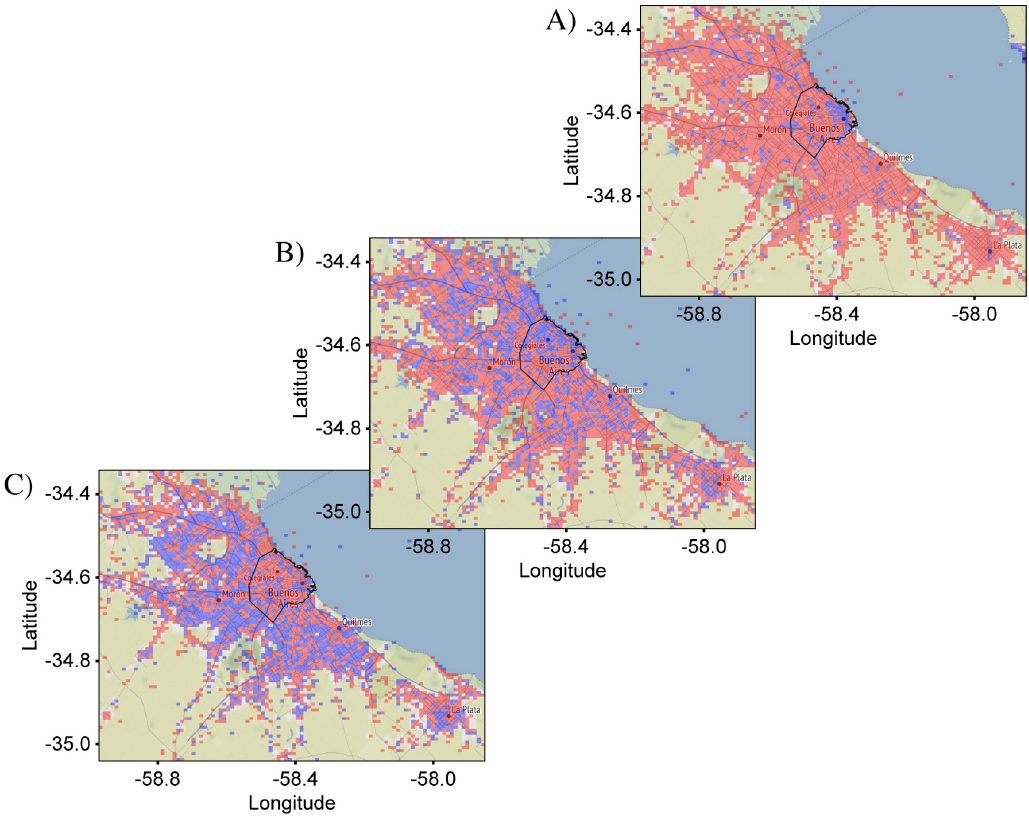
Fig 9. Comparison of differential distributions for three user cases with aspects of “foreignness” plotted over CABA+. (A) Foreign vs. local users. Blue represents the locations from which foreign users (i.e., from foreign countries) tweet more prominently while red represents the locations from which local users (i.e., from CABA+) tweet more prominently. (B) English vs. Spanish users. Blue (red) represents the locations from which English (Spanish) users tweet more prominently. (C) PanSp vs. ArgSp users. Blue (red) represents the locations from which Peninsular Spanish dialect users (Argentinian Spanish dialect users) tweet more prominently. The three cases show highly distinct patterns indicating that the users in each case and the corresponding geosocial drivers are most likely also distinct. Base map and data from OpenStreetMap and OpenStreetMap Foundation under the Open Database